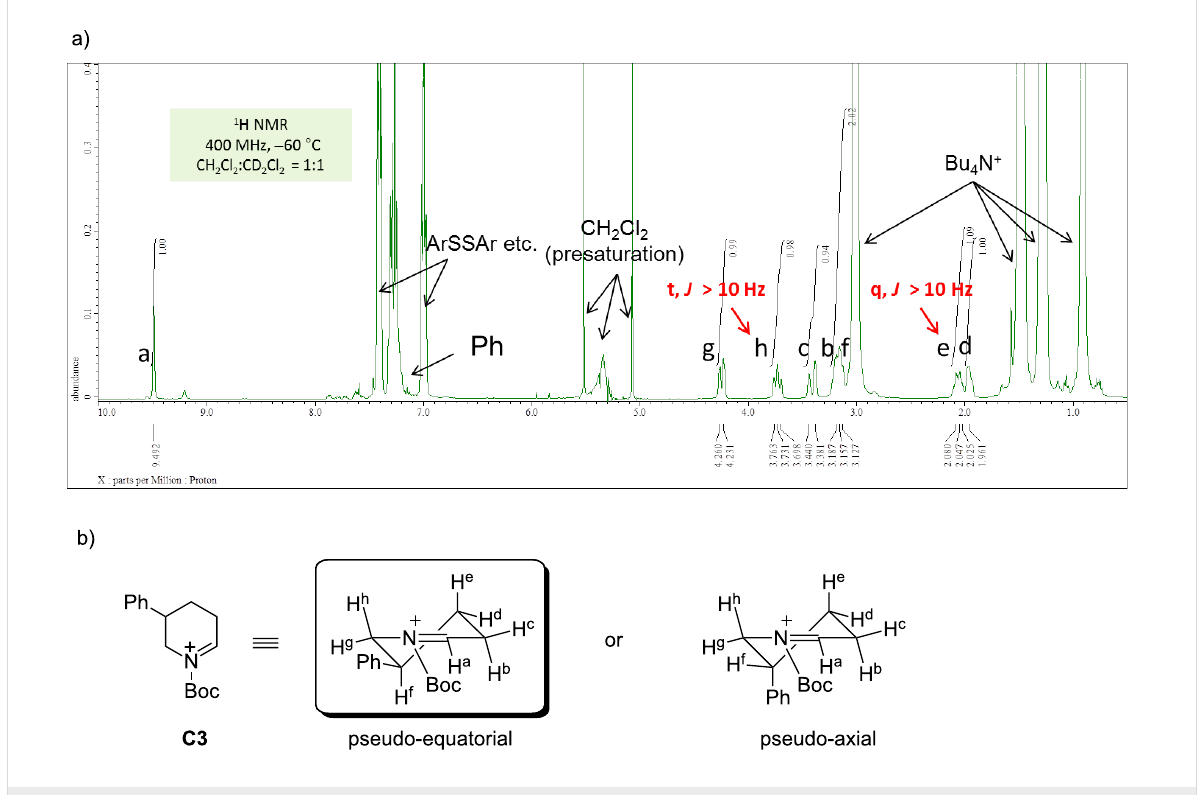
Figure 2: (a) 1 H NMR spectrum of C3 in CD 2 Cl 2 at − 60 °C (400 MHz). (b) Preferred conformation of C3 .